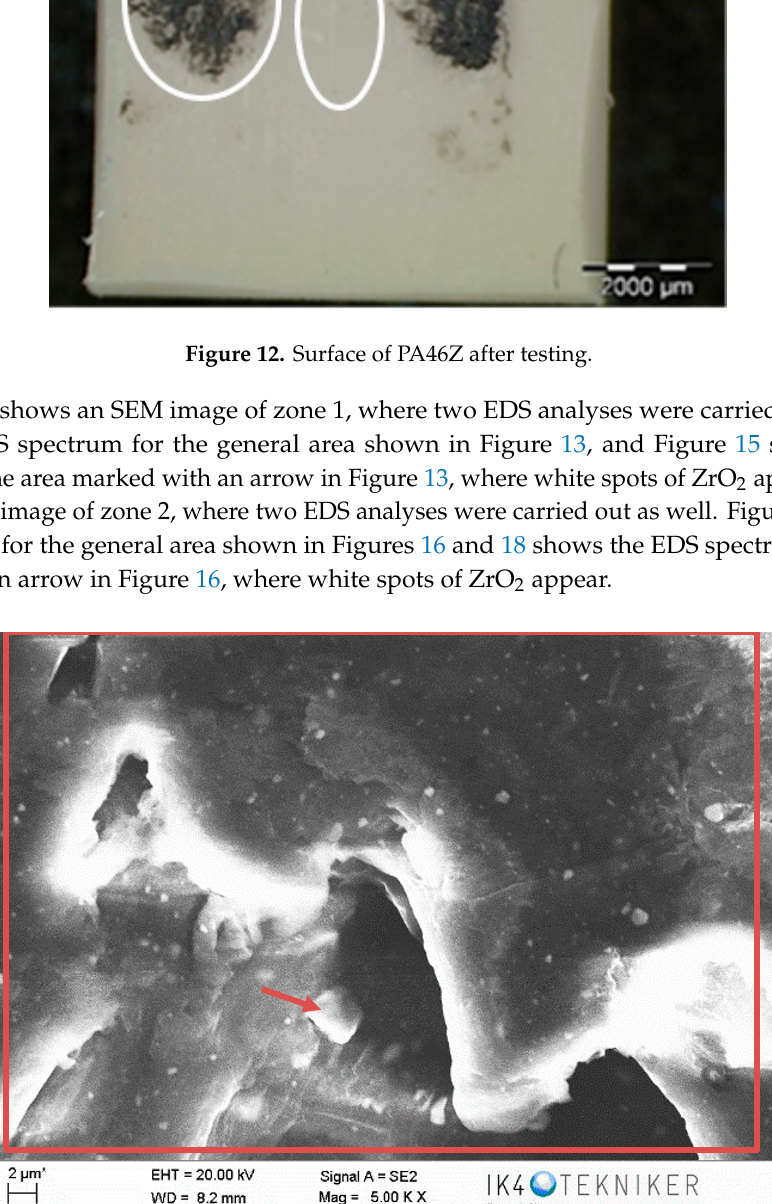
Figure 14. EDS spectrum for zone 1 in the PA46Z sample. Figure 15. EDS spectrum for zone 1 in a local area marked with an arrow in Figure 13, where ZrO 2 is located.